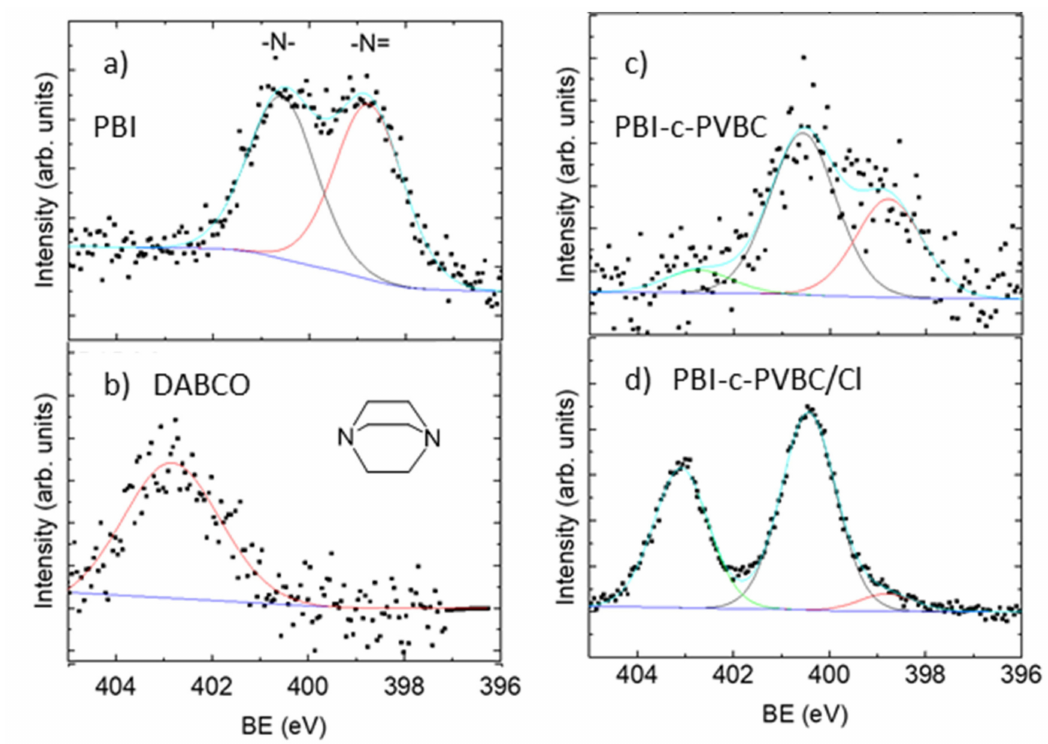
Figure 2. XPS N 1s peaks of ( a ) pristine polybenzimidazole (PBI), ( b ) pure DABCO, ( c ) PBI-c-PVBC 1:2 membrane (crosslinked) and ( d ) PBI-c-PVBC / Cl 1:2 membrane (after quaternization with